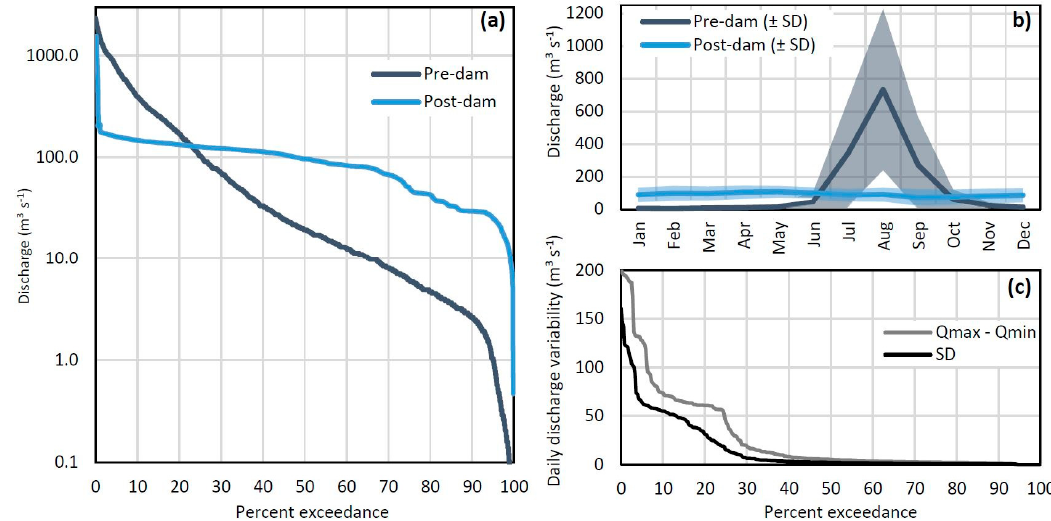
Figure 3. Hydrologic changes of the Tekeze River near the dam site: flow duration curves for average daily discharges ( a ), average pre-dam and post-dam monthly discharges ( b ) and daily post-dam variability in discharges for hydrologic year 2018, expressed as the observed maximum jump (Q max – Q min ) and standard deviation in hourly discharges within a one day-timeframe ( c ) (Data sources: [38,39,49]).